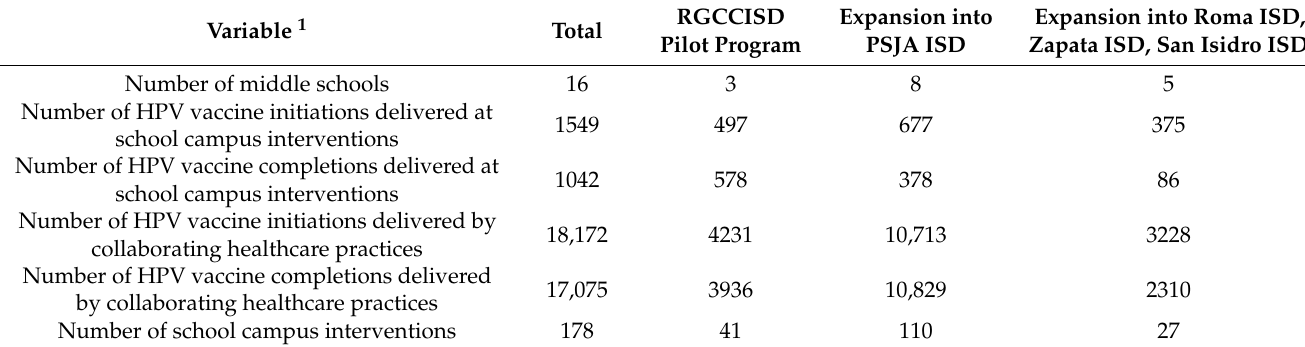
Table 1. Summary of HPV vaccine activities between August 2016 and August 31,